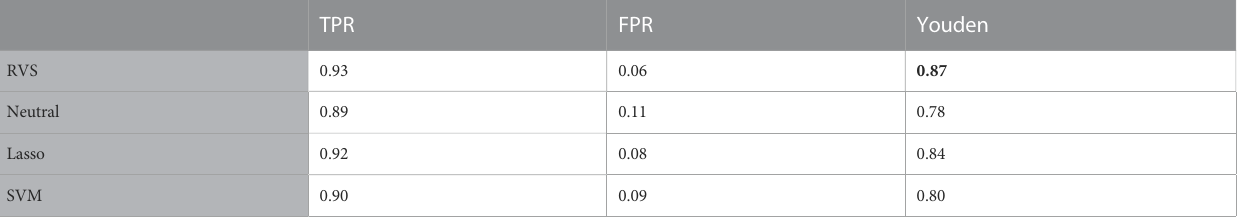
TABLE3Classi fi cationaccuracy:Thetruepositiverate(TPR),falsepositive rate(FPR),andYouden ’ sIndexforgroupclassi fi cation,forthebalancedsimulateddata. All metrics are averaged over 100 simulated data sets. The highest Youden's index value is indicated in bold. TPR FPR Youden